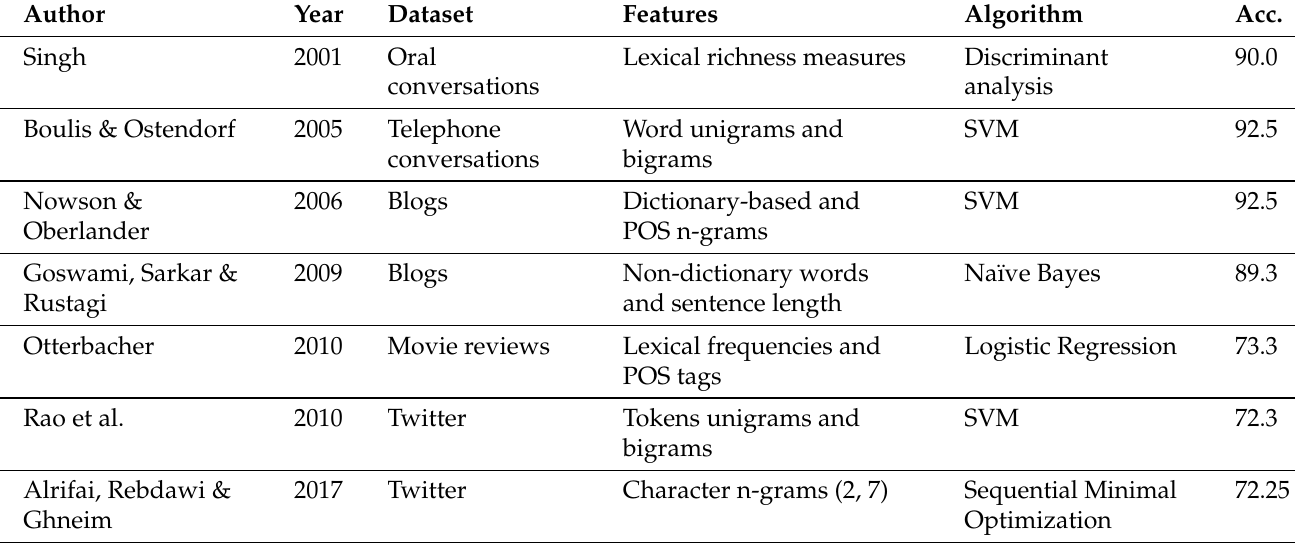
Table 1. Previous work on automatic gender